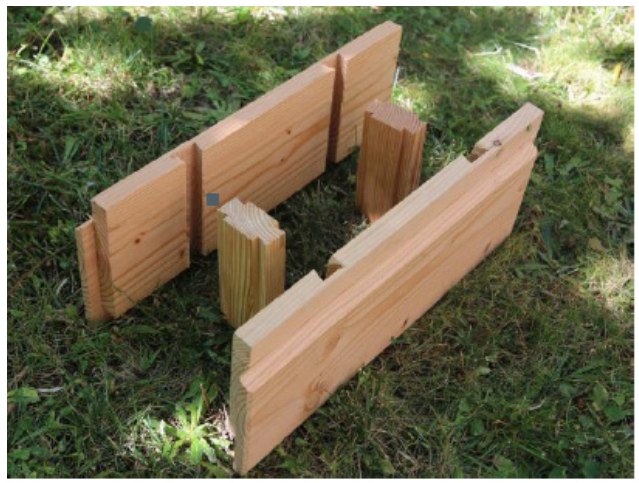
Figure 6. Wooden box elements [10].